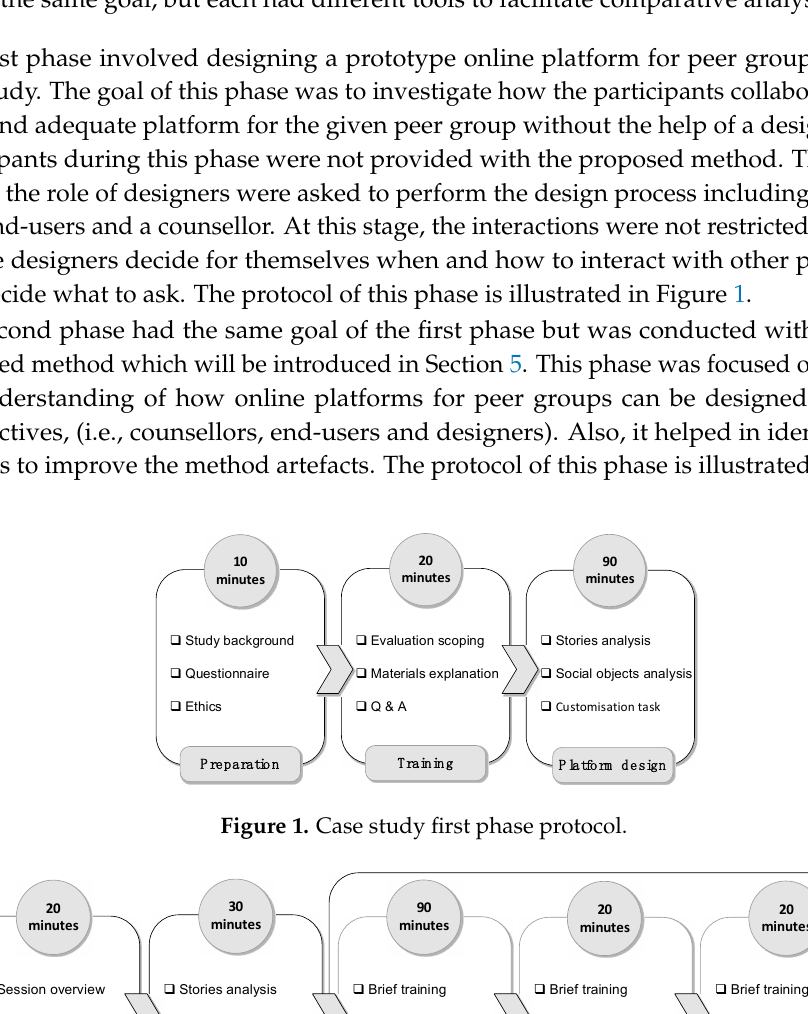
Figure 1. Case study first phase protocol.